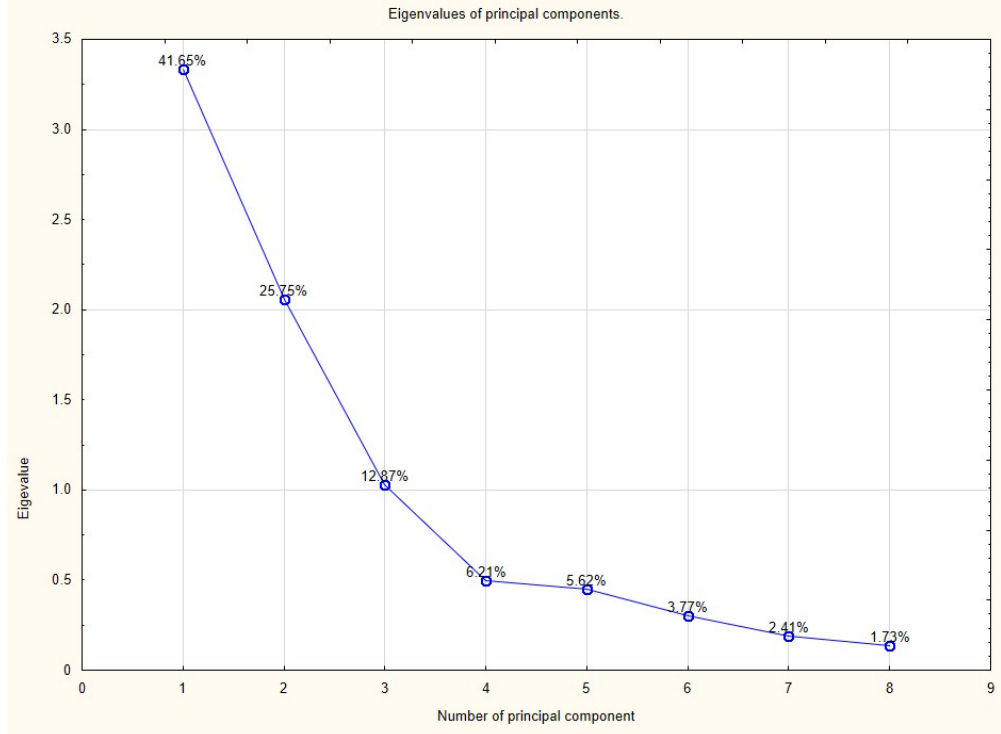
Figure 1. Scree plot. Each point is described by the percentage of the total variance explained by that component.